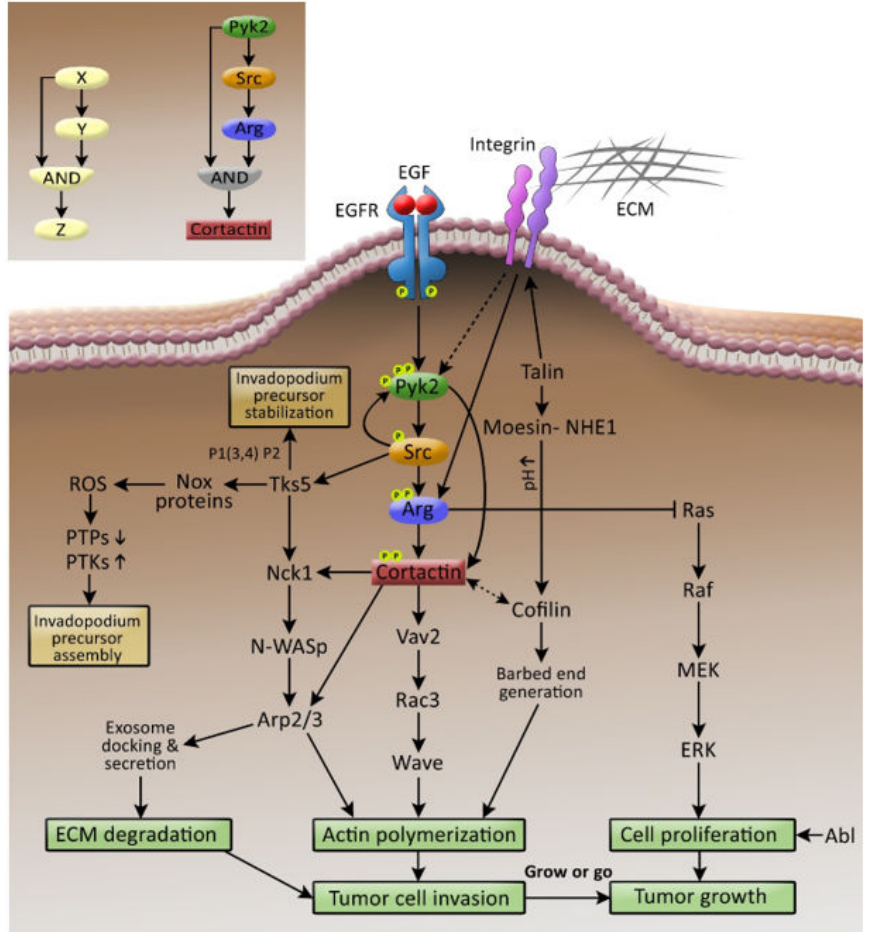
Figure 1. Pyk2-mediated signaling in invadopodia. Extracellular stimulation by EGFR and integrins leads to activation of Pyk2, which tyrosine phosphorylates cortactin both directly and indirectly by activating Src and Arg kinases. Activation of Src leads to invadopodium precursor assembly and stabilization by recruiting and phosphorylating Tks5. Complete tyrosine phosphorylation of cortactin leads to activation of several signaling pathways, which induce actin polymerization and ECM degradation and consequent invadopodia-mediated tumor cell invasion, intravasation, and metastatic dissemination. While promoting cell invasion and dissemination, Arg simultaneously inhibits the Ras-MAPK pathway, which induces cell proliferation and consequent tumor growth, acting as a switch in metastatic cancer cells that govern the decision to “grow or go” (divide or invade). Inset: the coherent type I feedforward loop with AND gating (left) parallels the Pyk2-Src-Arg-cortactin pathway (right). The different NRTKs, their substrates, and invadopodial roles are described in Table 1. In systems biology terms, the invadopodial Pyk2-mediated signaling pathway is considered as a coherent type I feedforward loop with AND gating [41], where protein X (Pyk2) activates protein Z (cortactin) both directly and indirectly via protein Y